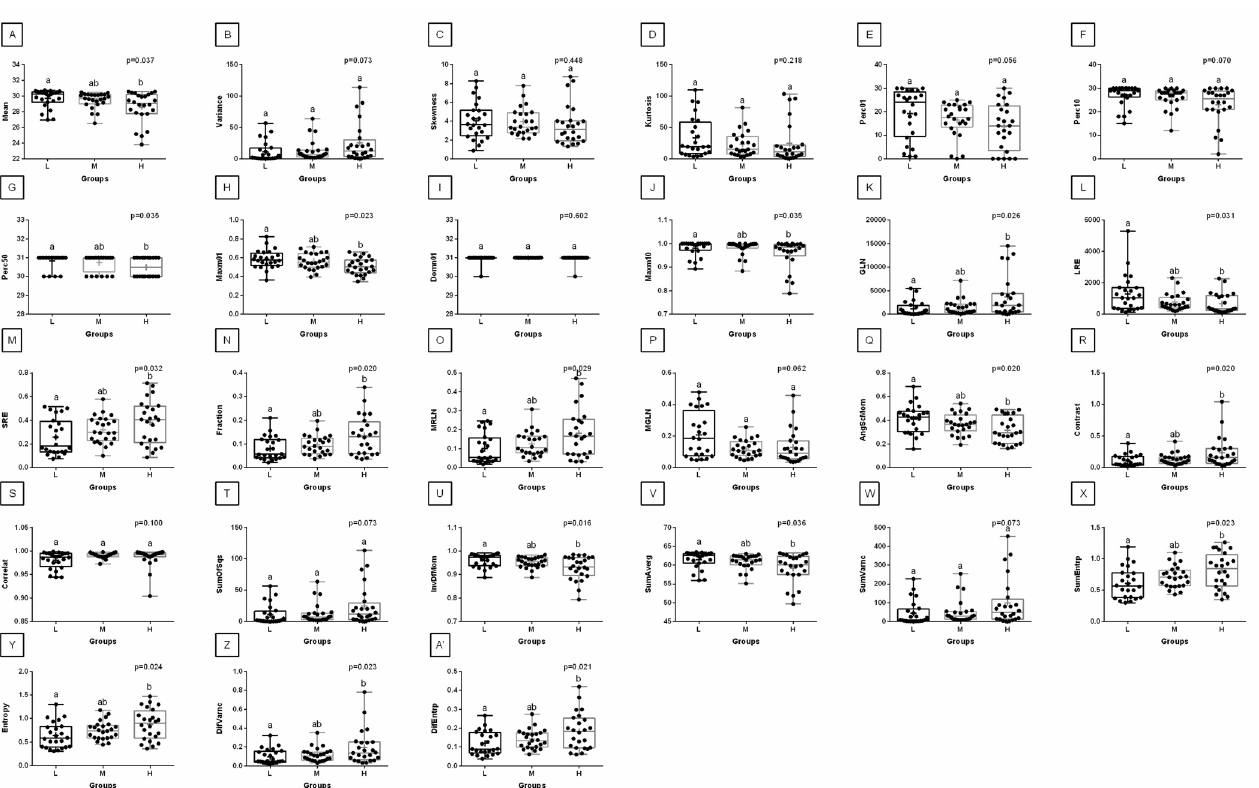
Figure 9. Analysis of texture features for the red component compared between light (L), mod- erate (M), and heavy (H) groups in the third region of interest (ROI 3). Differences between groups were indicated with individual p -values when p < 0.05. Different superscripts on